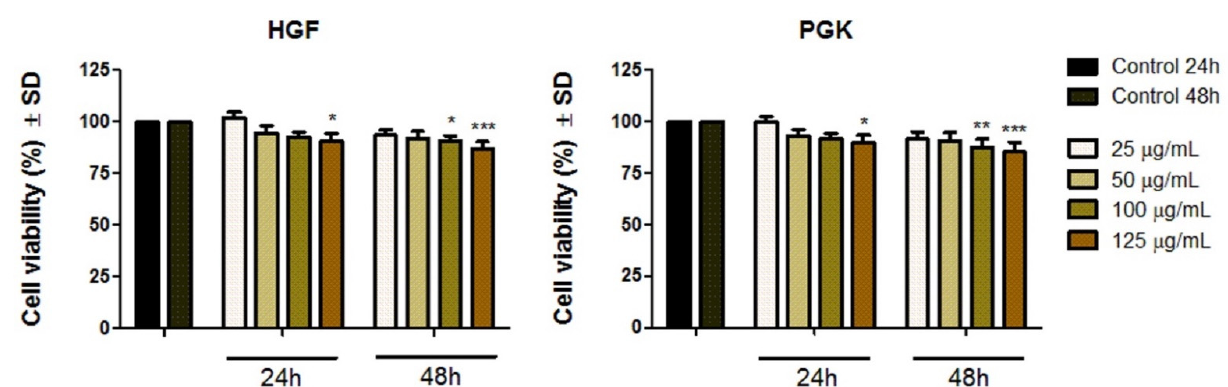
Figure 8. Cell viability percentage of primary human gingival fibroblasts (HGFs) and primary gingival keratinocytes (PGKs) at 24 h and 48 h post-stimulation with the Fe 3 O 4 @Carbon sample at different concentrations (25, 50, 100, 125 µg/mL). The results are presented as mean values of the cell viability percentage (%) normalized to control cells (treated with cell culture media) ± Standard Deviation (SD). One-way ANOVA was applied to determine the statistical differences between test-treated cells and the control, followed by Tukey’s multiple comparisons test (* p < 0.05; ** p < 0.01; *** p < 0.001 versus control cells).